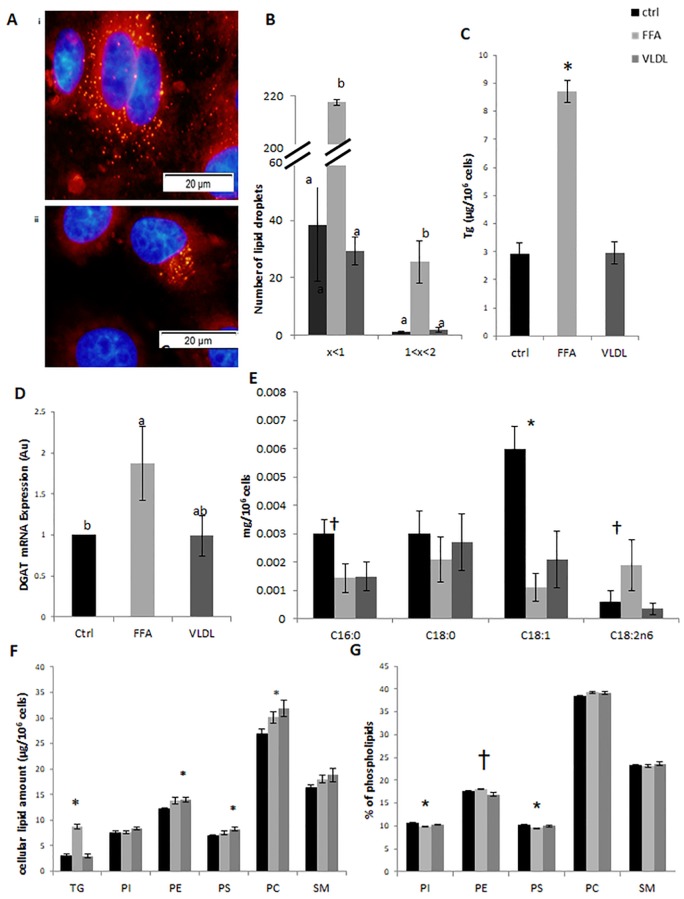
Long chain fatty acid macro structure change LD size and membrane phospholipid composition in a different manner.Mammary epithelial cells (MEC) were treated with 100 μM very-low-density lipoprotein (VLDL) or 100 μM free fatty acids (FFA) for 24 h. (A) MEC nuclei was stained with DAPI (blue) and neutral lipids were stained with Nile red (red). LD were more numerous and larger under the FFA treatment (i, top) compared to VLDL (ii, bottom). Scale bars, 20 μm. (B) Number of LD by size category (>1 μm, between 1 and 2 μm) in control (black), FFA (light gray) and VLDL (dark gray) treatments, n = 4 for each replicate in each treatment, total of 4 replicates (C) Intracellular triglyceride (Tg) amount determined by HPLC–ELSD (P < 0.0001). (D) Diacylglycerol acyltransferase (DGAT) mRNA expression (AU). *P < 0.05. (E) Fatty acid (FA) amount in cells (μg/106 cell) analyzed by GC. (F) Membrane phospholipid (PL) concentration (μg/106 cell) analyzed by HPLC-ELSD (G) PL membrane composition (weight %) analyzed by HPLC-ELSD n = 4 for each replicate in each treatment, total of 3 replicates.